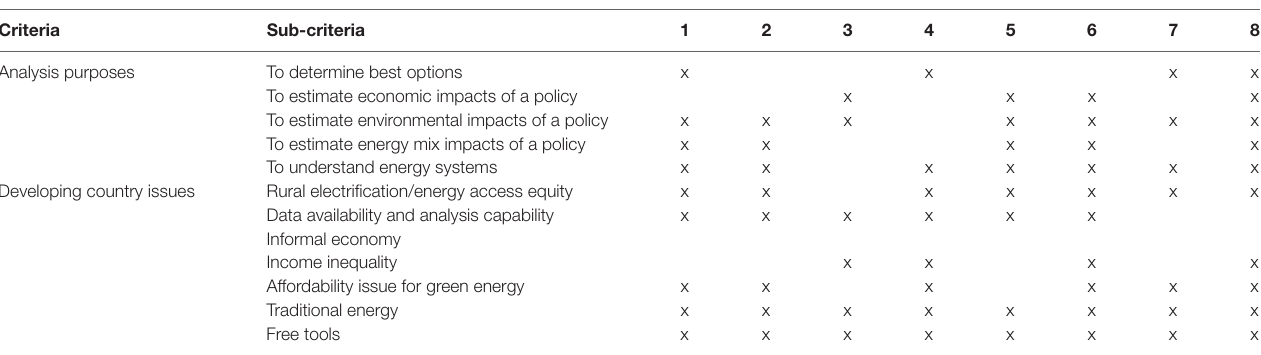
TABLe 2 | Common features of energy tools